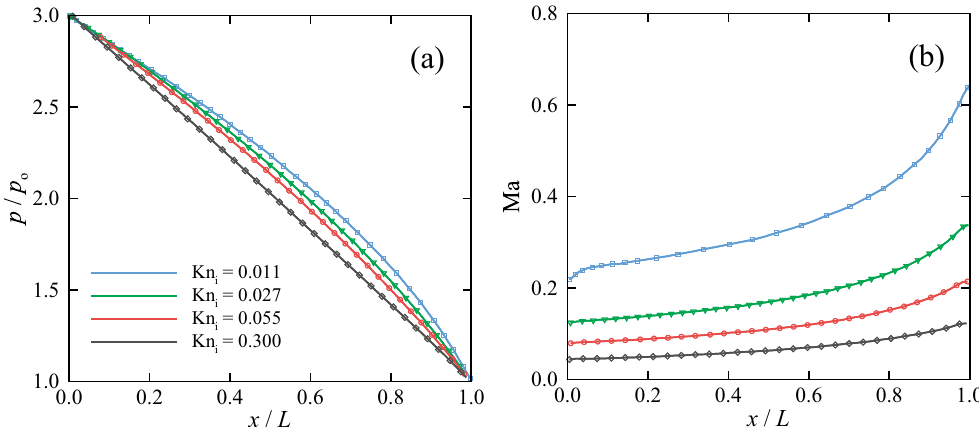
Figure 2. Comparison of the numerical results obtained from the present model (solid lines) with the data reported by White et al. [64] (symbols) for pressure-driven rarefied argon flow in a mi- crochannel with a uniform cross-section. Profiles of ( a ) pressure and ( b ) Mach number along the mi- crochannel